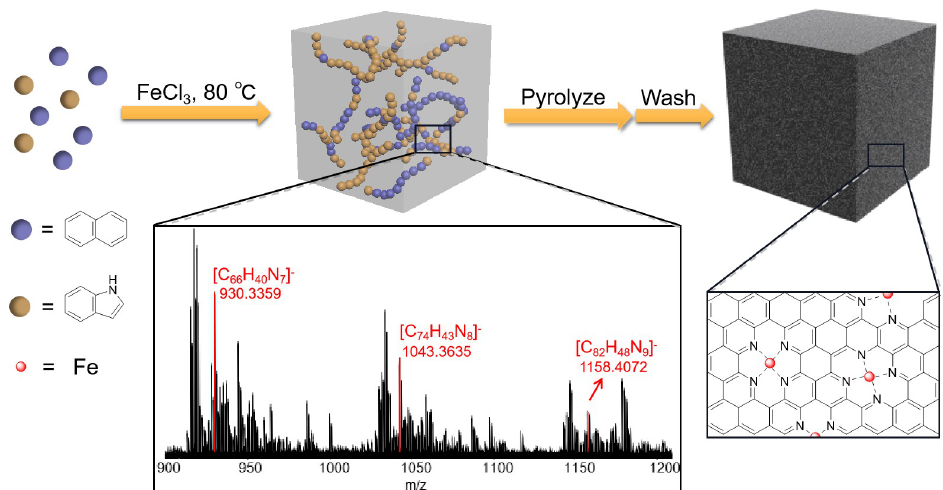
Figure 1. Schematic illustration of the synthesis procedure of the SA-Fe@NC.